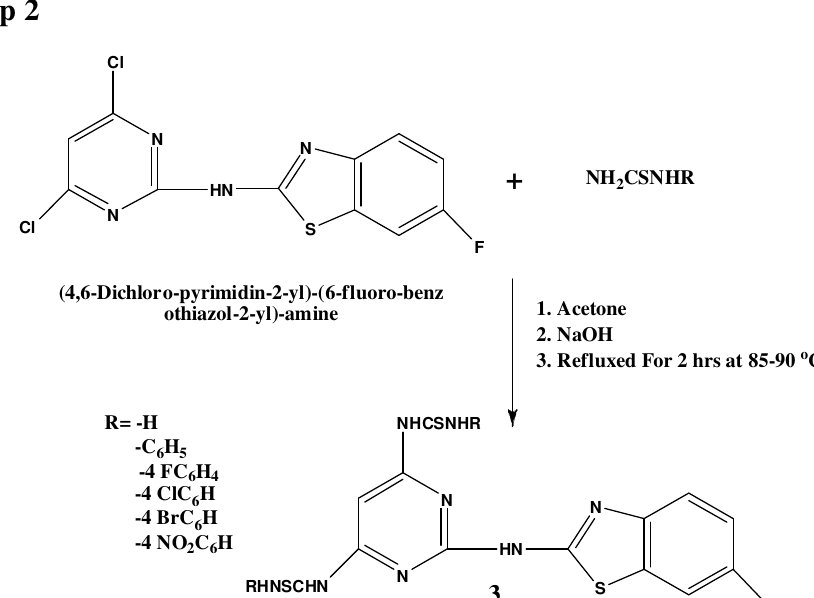
Scheme 1. Synthetic procedure for preparation of 2-(6’-fluorobenzothiazol-2’-ylamino)-4,6- (disubstituted thiouriedo)-1,3-pyrimidine derivatives Compound